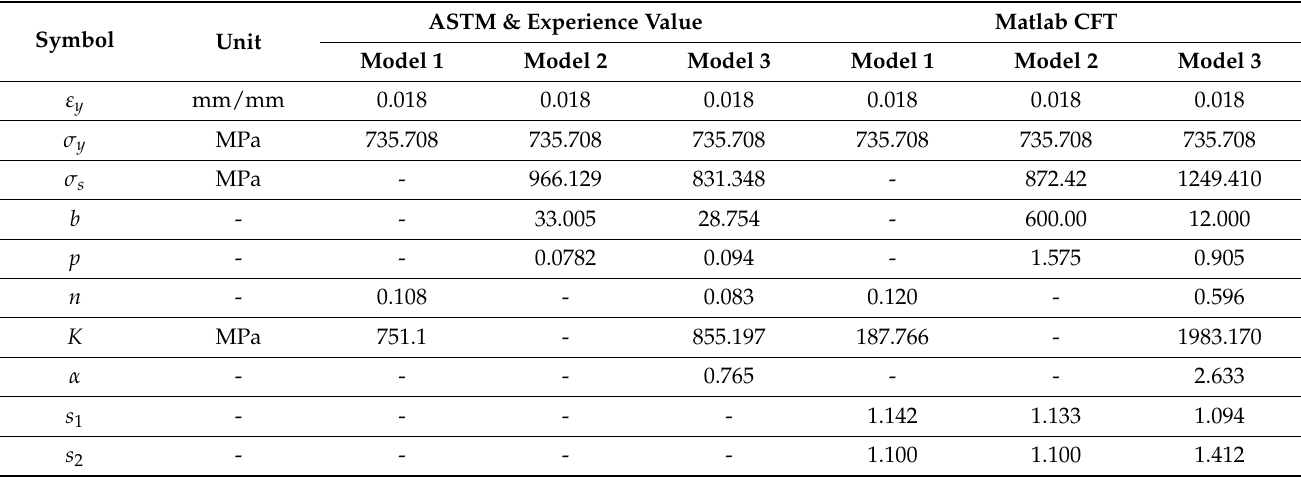
Table 4. Definition of parameter for constitutive model.